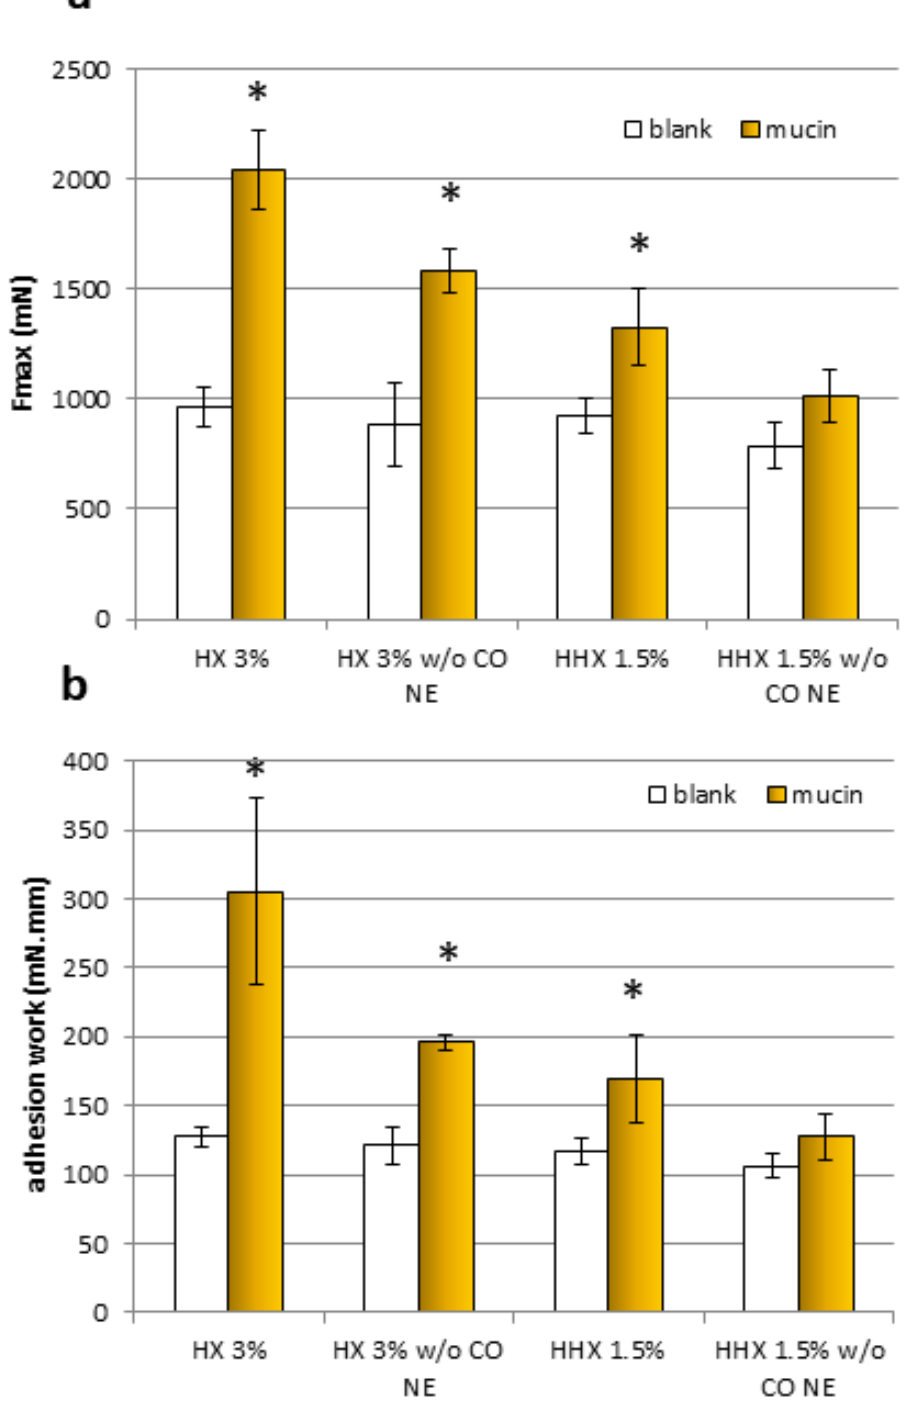
Figure 6. The maximum force of detachment, Fmax ( a ), and work of adhesion ( b ) for the samples, HX 3% and HHX 1.5%, and for the HEC alone at the same concentrations ( w / o EO NE) (mean ± sd; n = 3). * Indicates samples statistically different from the corresponding blanks (Student’s t -test, p < 0.05).